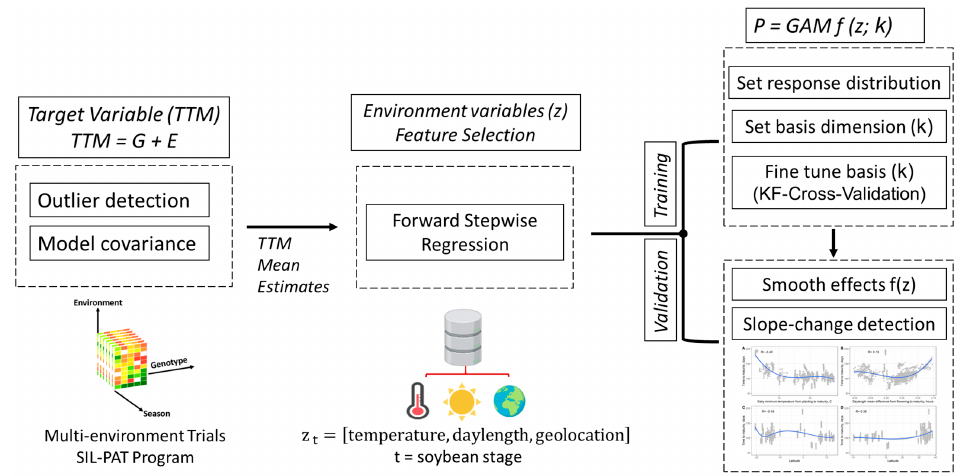
Figure 1. Steps to implement a generalized additive model (GAM) to predict soybean time to maturity (TTM), based on seasonal characterization and resources from a breeding program in Africa.